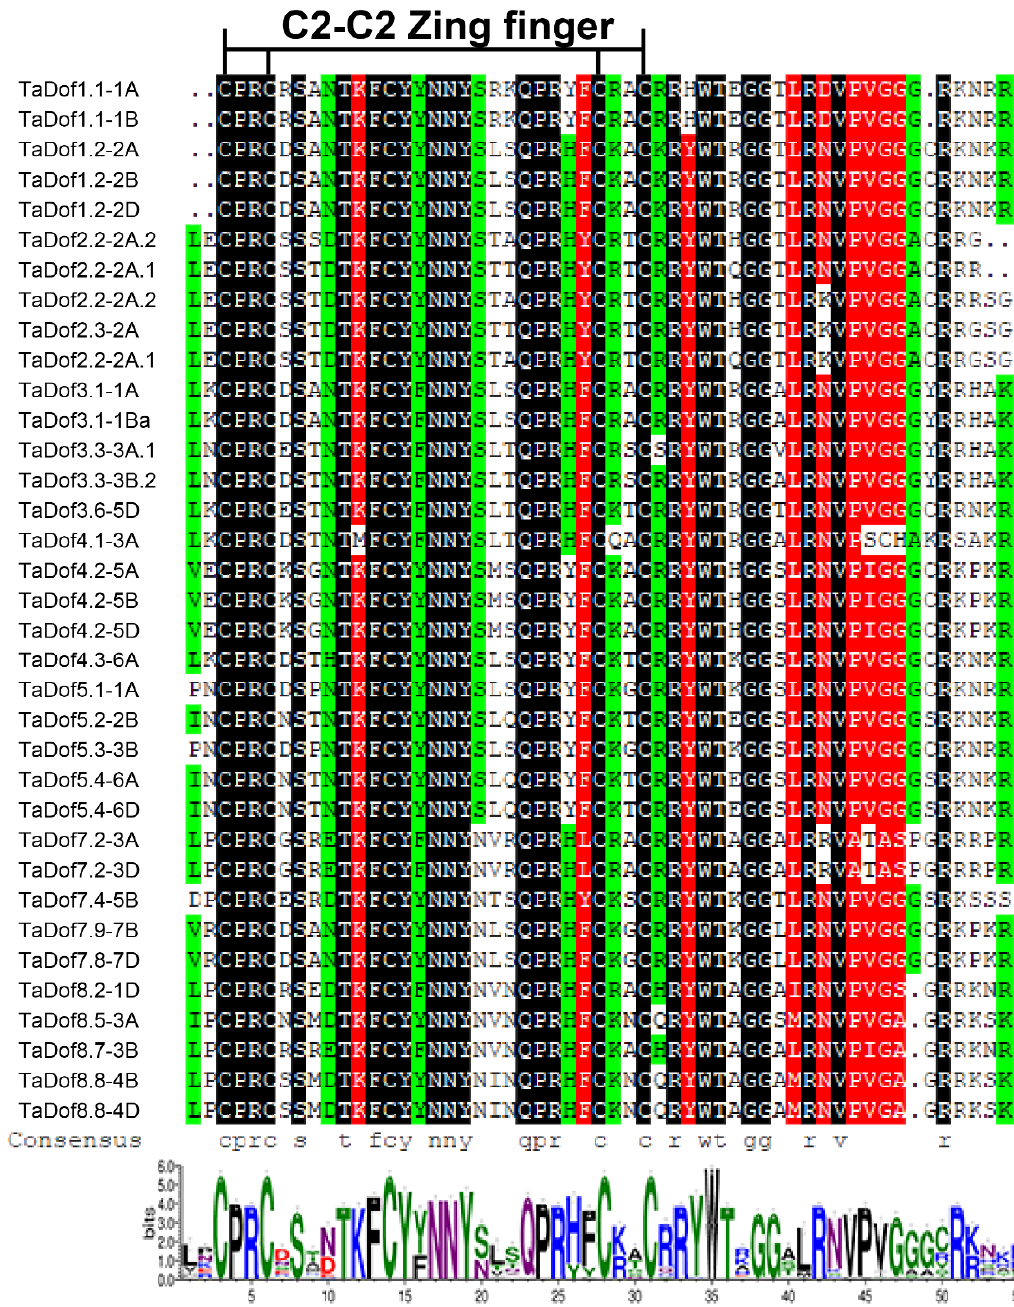
Figure 2. Multiple sequence alignment of Dof domains in identified wheat Dof proteins. Sequences were aligned using MEGA7.0, and manually refined. Identical amino acids are shown at the bottom and the four cysteine residues are indicated at the top. A sequence LOGO view based on the sequence alignment is shown at the bottom.